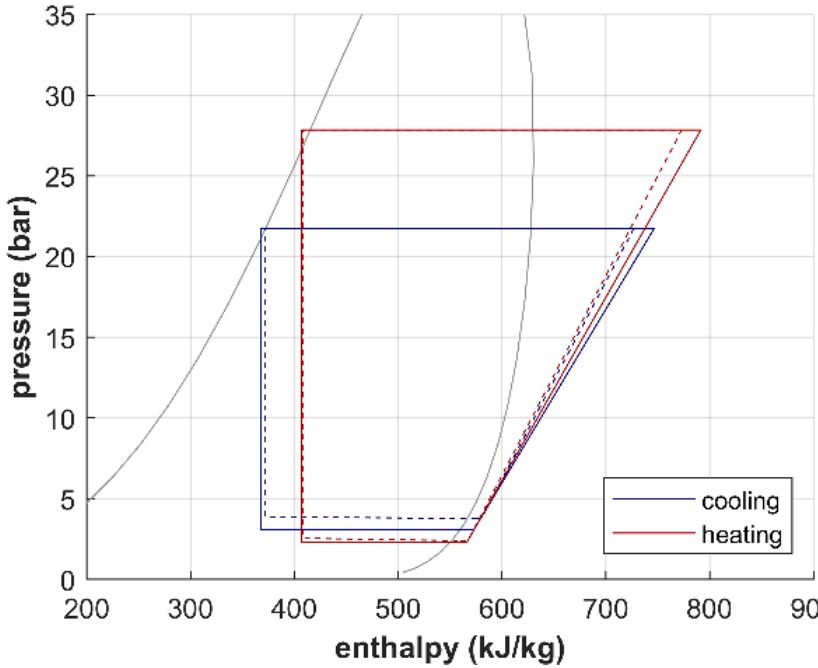
Figure 5. p,h diagram for model validation in cooling and heating